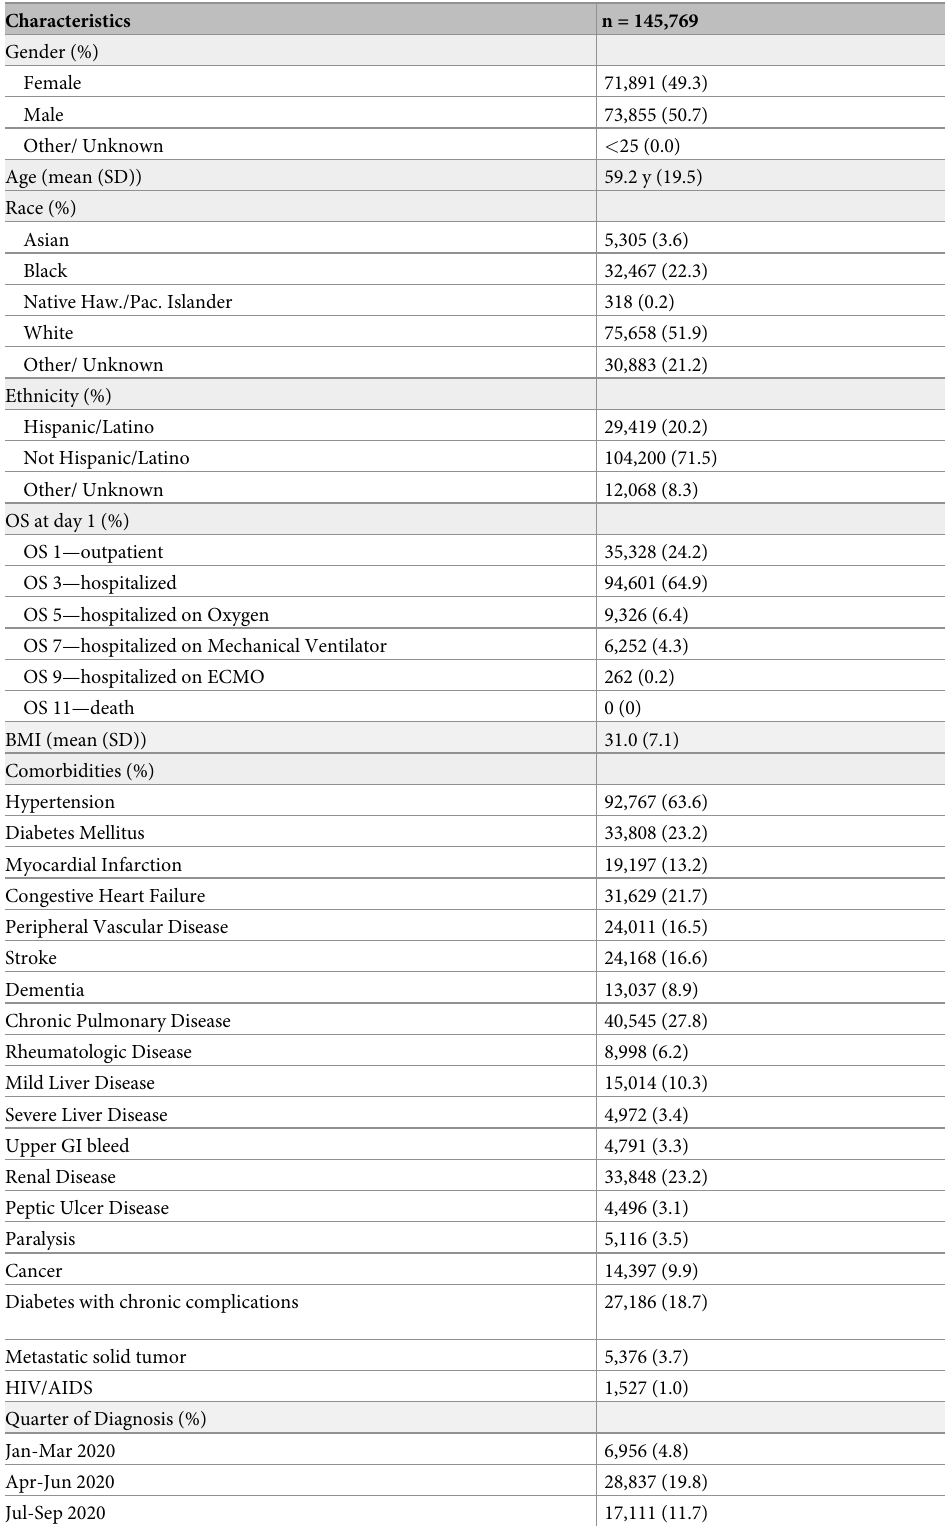
Table 2. Patients’